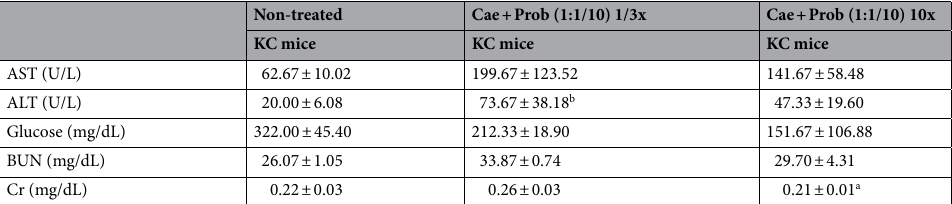
Table 3. Comparison of biochemical values in KC transgenic mice after treatment with caerulein (Cae) and different doses of probiotics. ALT, alanine aminotransferase; AST, aspartate aminotransferase; BUN, blood urea nitrogen; Cae + Prob (1:1/10) 1/3x, caerulein(25 μg/kg) + probiotics (GMNL133:GMNL89 = 1:1/10, 1/3 times); Cae + Prob (1:1/10) 10x, caerulein (25 μg/kg) + probiotics(GMNL133: GMNL89 = 1:1/10, 10 times);